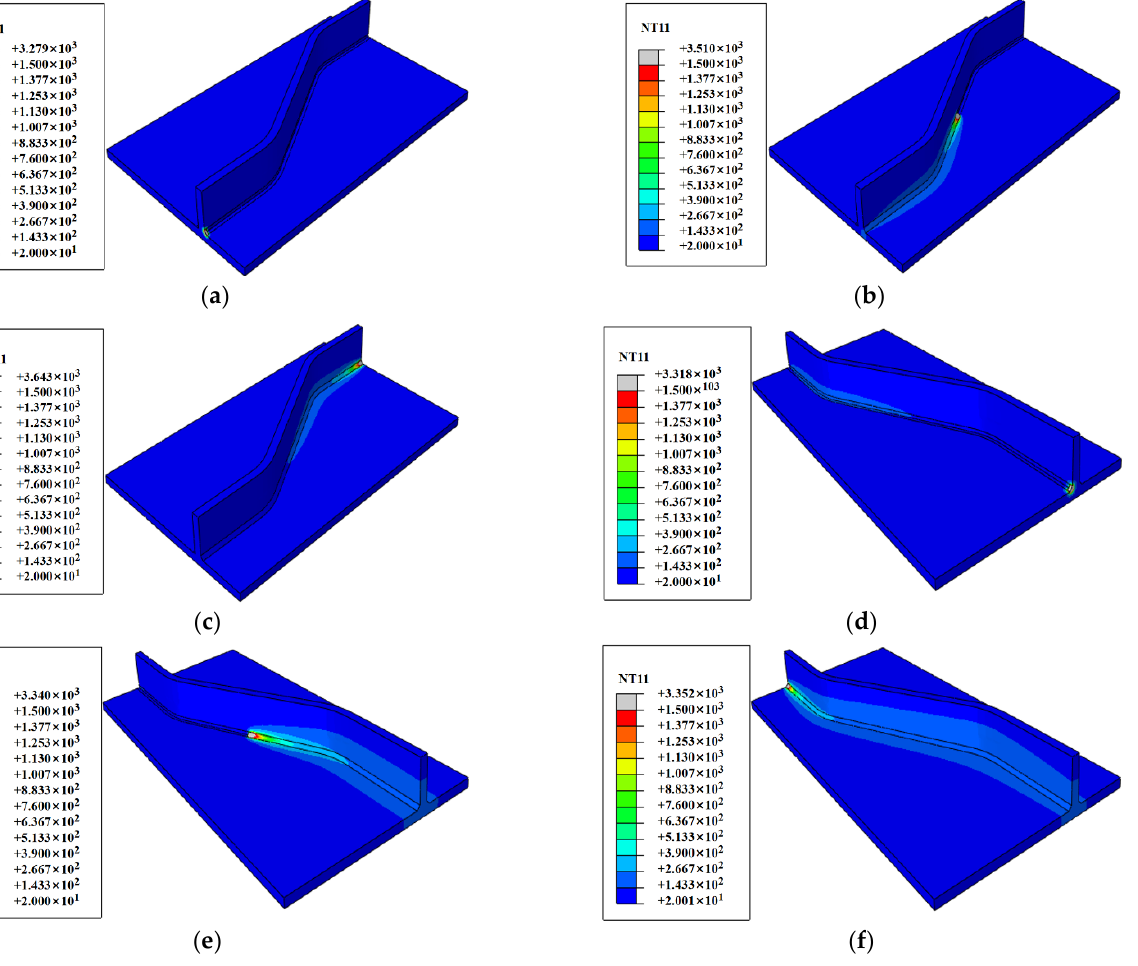
Figure 10. Time course of temperature field cloud image in welding stage (unit: °C); ( a ) Temperature field at 1 s; ( b ) Temperature field at 86 s; ( c ) Temperature field at 172 s; ( d ) Temperature field at 174 s; ( e ) Temperature field at 260 s; ( f ) Temperature field at 346 s.